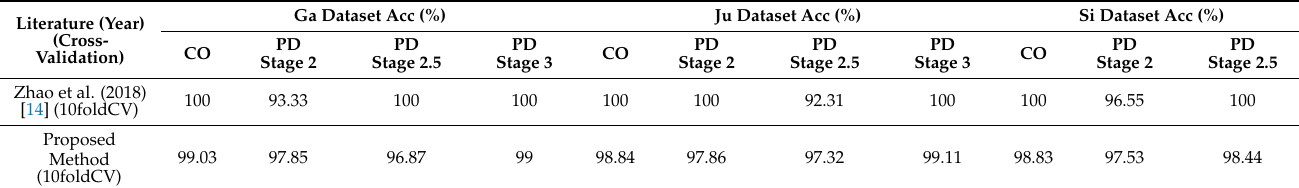
Table 24. Multi-class classification results of comparisons with existing